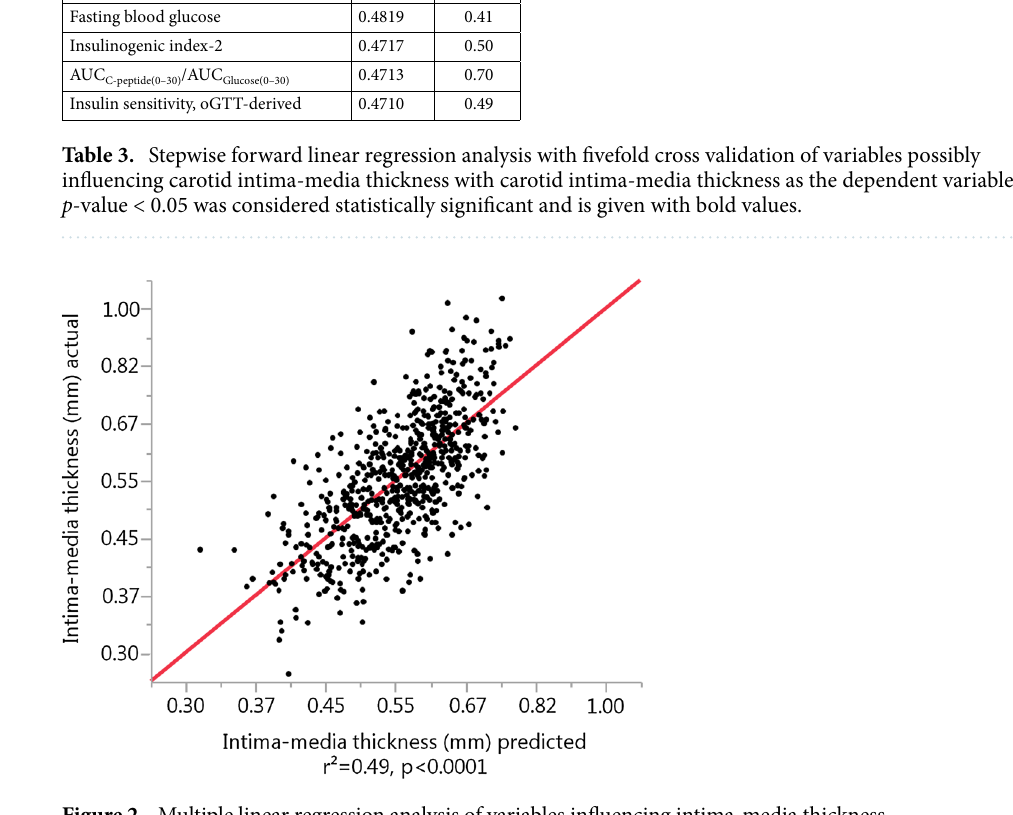
Figure 2. Multiple linear regression analysis of variables influencing intima-media thickness.